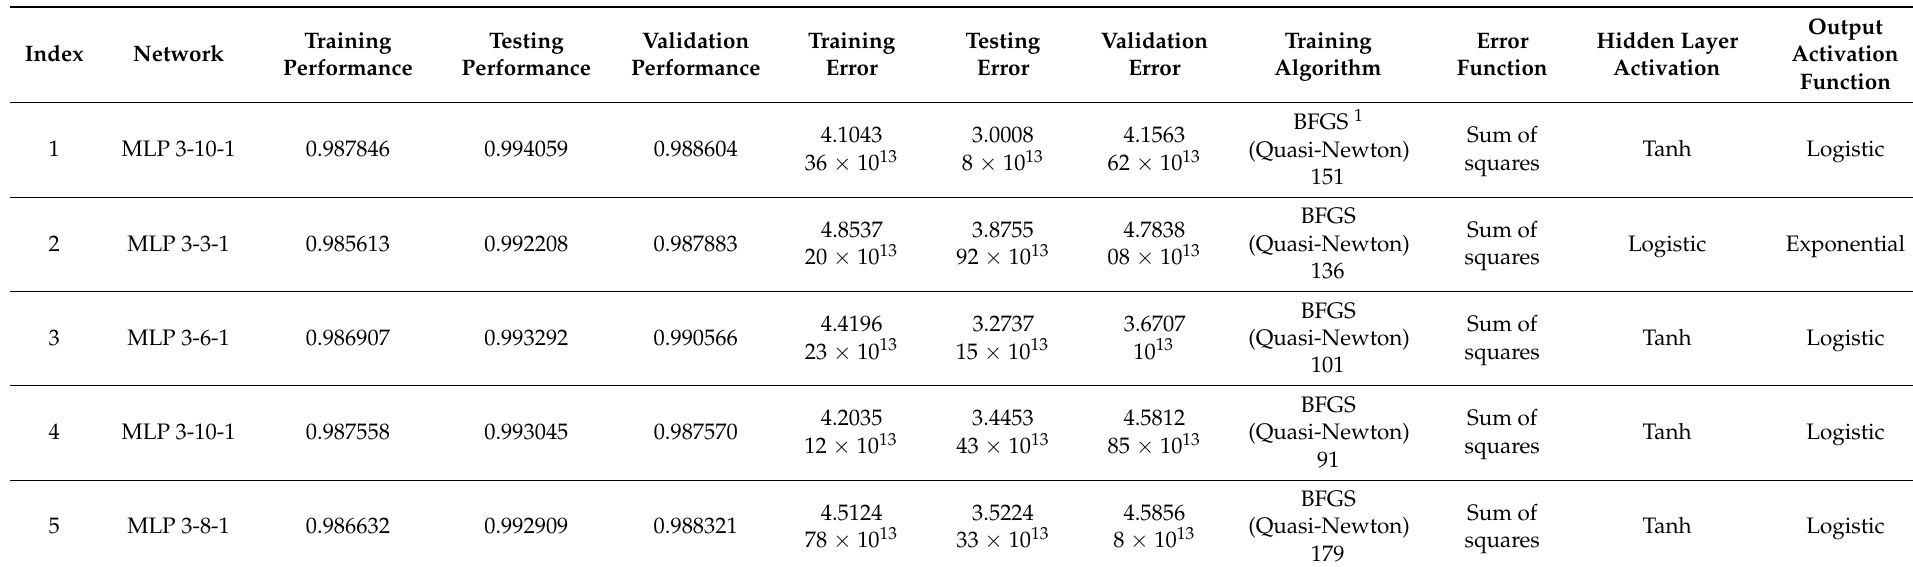
Table 2. Retained neural networks from Experiment